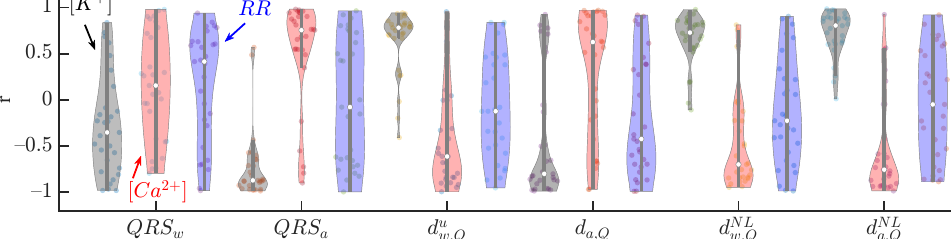
Figure 5. Pearson correlation coefficients between QRS markers ( QRS w , QRS a , d u d NL ) and [ K + ] (black), [ Ca 2 + ] (red) and RR (blue) for all patients at all HD points. The central white a,Q dot indicates the median. Each dot corresponds to an individual patient.